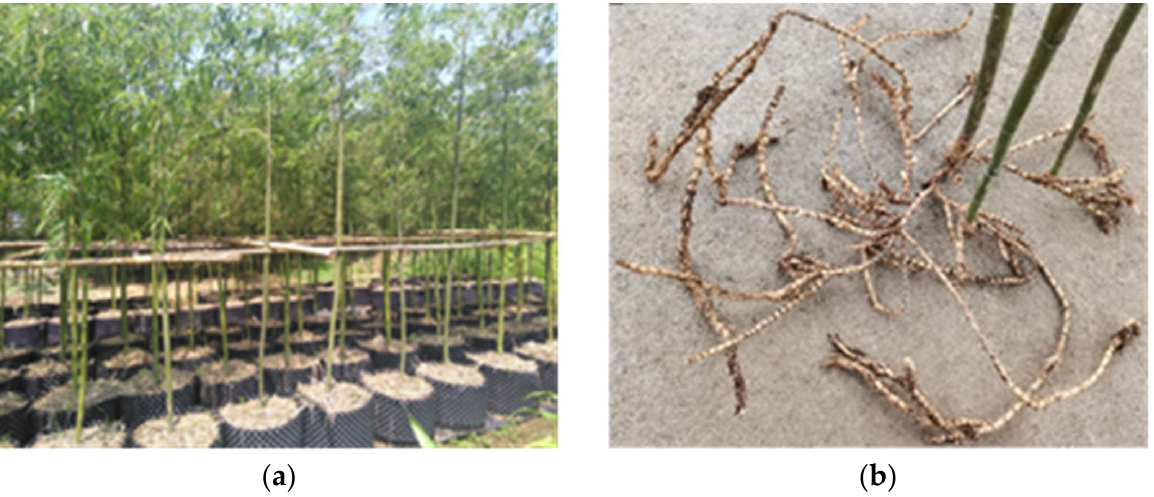
Figure 2. Potting of mother bamboo and investigation of rhizome. ( a ) Potted mother bamboo; ( b ) sampling of rhizome.